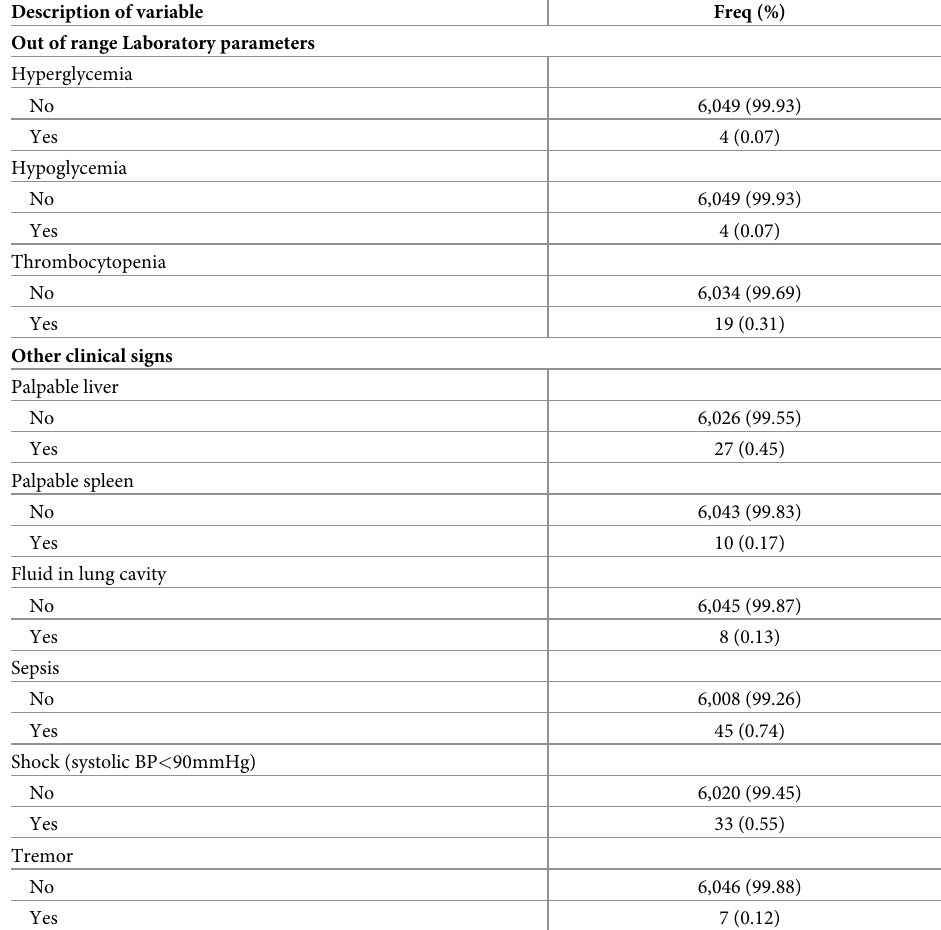
Table 3. Distribution of out-of-range laboratory parameters and other clinical signs among study